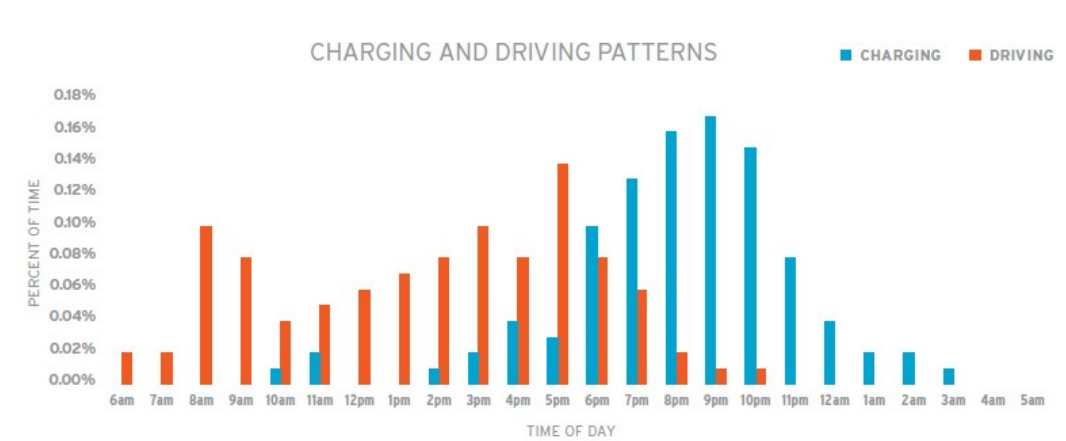
Figure 7. Driving patterns